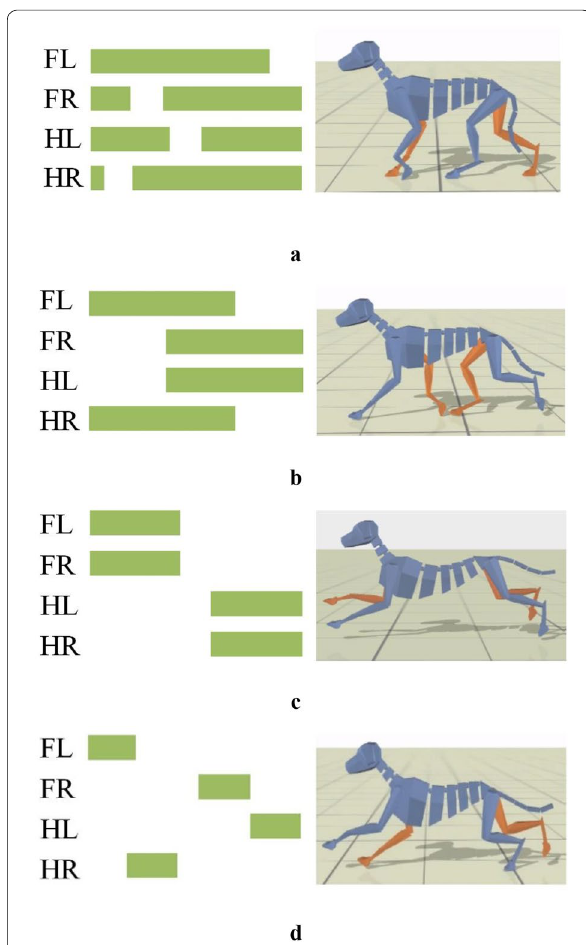
Figure 16 Gait graphs for quadrupedal mammals [79]: a walk; b trot; c bound; d